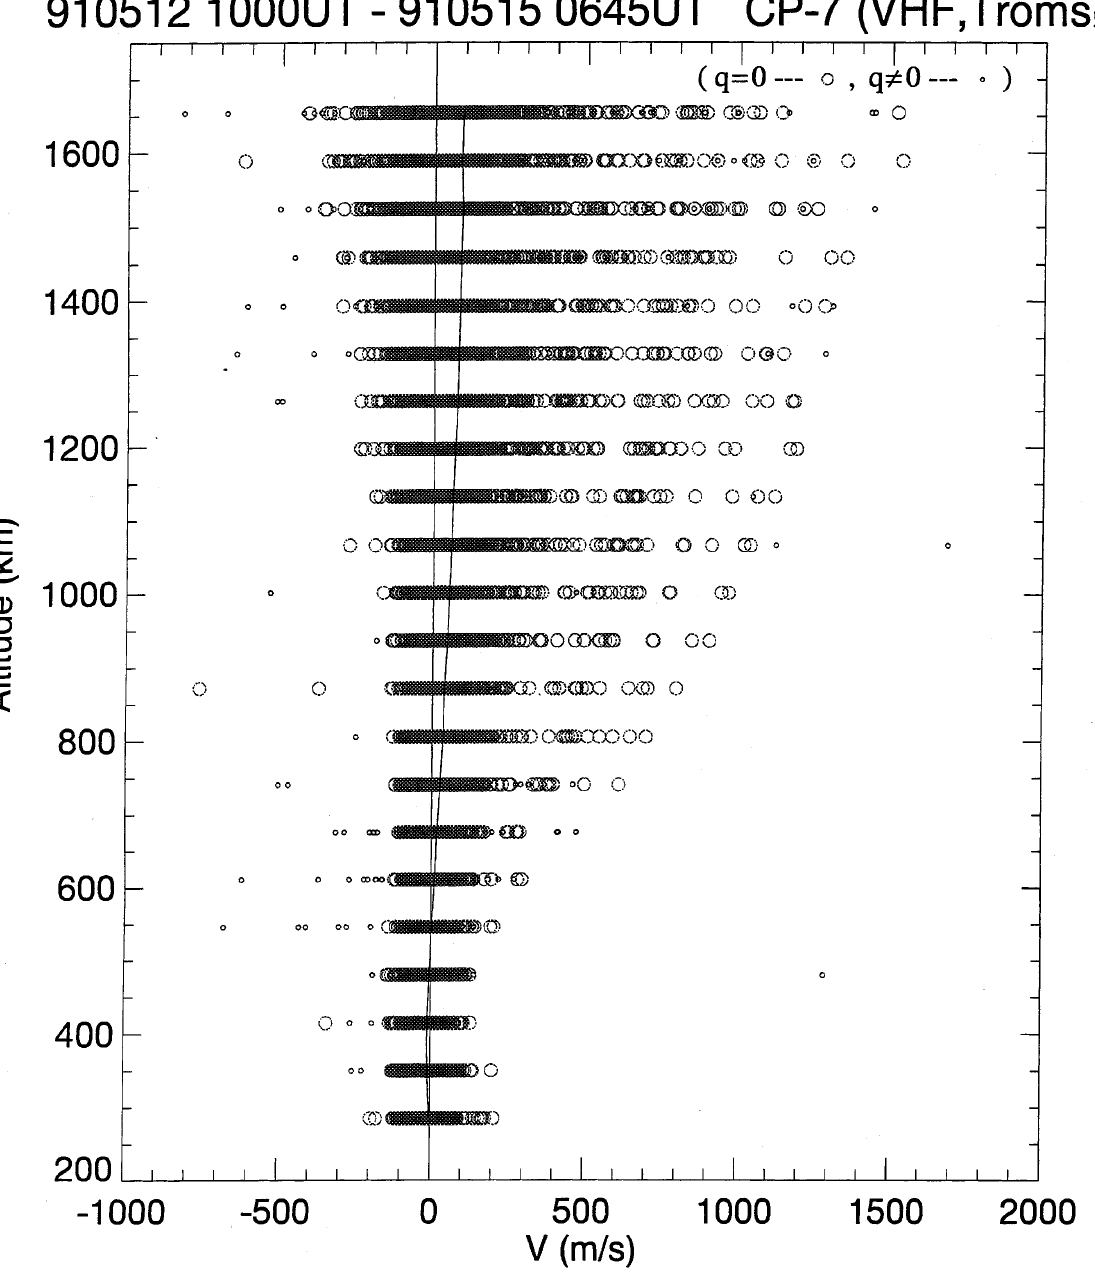
velocity range around zero. The ion velocity for other data shows that the ion upflow starts to appear at altitude, often above